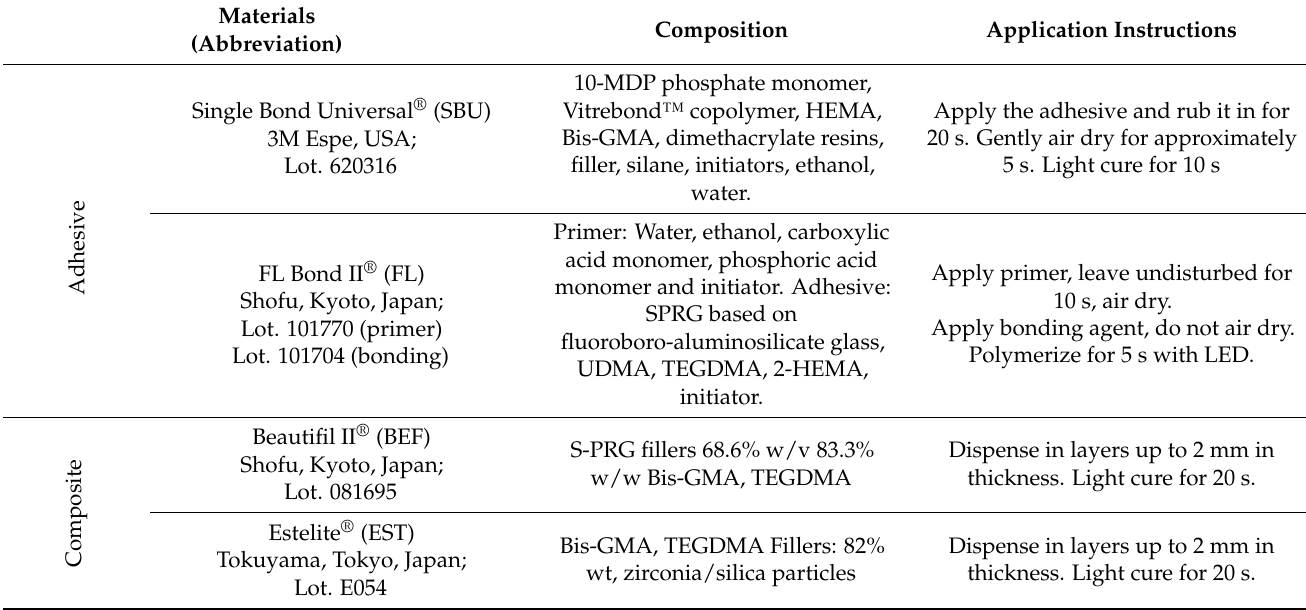
Table 1. Materials used in this study.